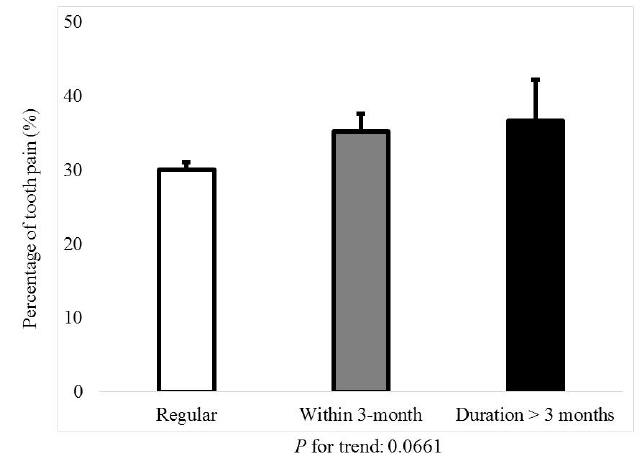
Figure 2. Percentage of tooth pain according to menstrual cycle categorization of regular, irregular (once within 3 months), and duration longer than 3 months.